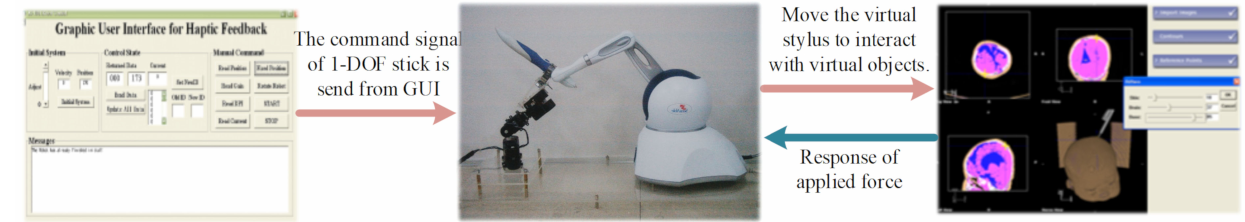
Figure 8. Experimental platform for task of one-dimensional